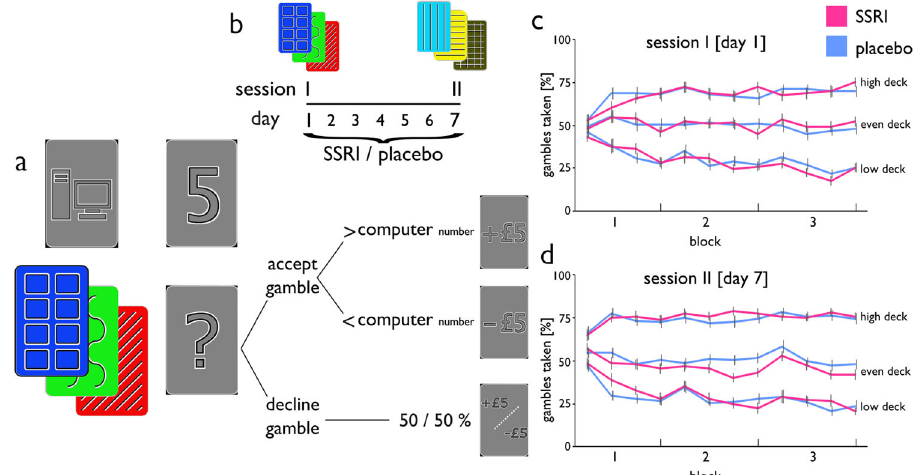
Fig. 1 Experimental task, pharmacological procedure, and learning performance. a Experimental design: On each trial, participants were presented with one of three possible decks and a number between 1 and 9 drawn by the computer. If participants decided to gamble, they won £5 if the number they drew was higher than the computer drawn number, and lost £5 if the number was lower. Participants were only informed whether they won or lost the gamble, not which number they drew. Participants had to learn by trial and error how likely gambles were to succeed with each of the three decks. One deck contained a uniform distribution of numbers between 1 and 9 (even deck), one deck contained more 1 ’ s (low deck), making gambles 30% less likely to succeed, and one deck contained more 9 ’ s (high deck), making gambles 30% more likely to succeed. Opting to decline the gamble resulted in a 50% probability of win/loss, regardless of which number was drawn by the computer. b Pharmacological procedure: Subjects were randomly allocated to take a daily dose of 20 mg citalopram or placebo for seven days and participated in two sessions: session I took place on day 1 after single administration, session II took place on day 7, at a time when citalopram reaches steady-state plasma levels. Subjects played an identical game on both sessions, but with two independent sets of three decks, where colour order and colour-associated win probability randomly varied across participants. c , d Learning performance: Gambles taken with each deck as a function of time. Percentages were computed separately for each set of 15 contiguous trials (4 sets/60 trials per block), for session I ( c ), and session II ( d ), respectively. Error bars indicate